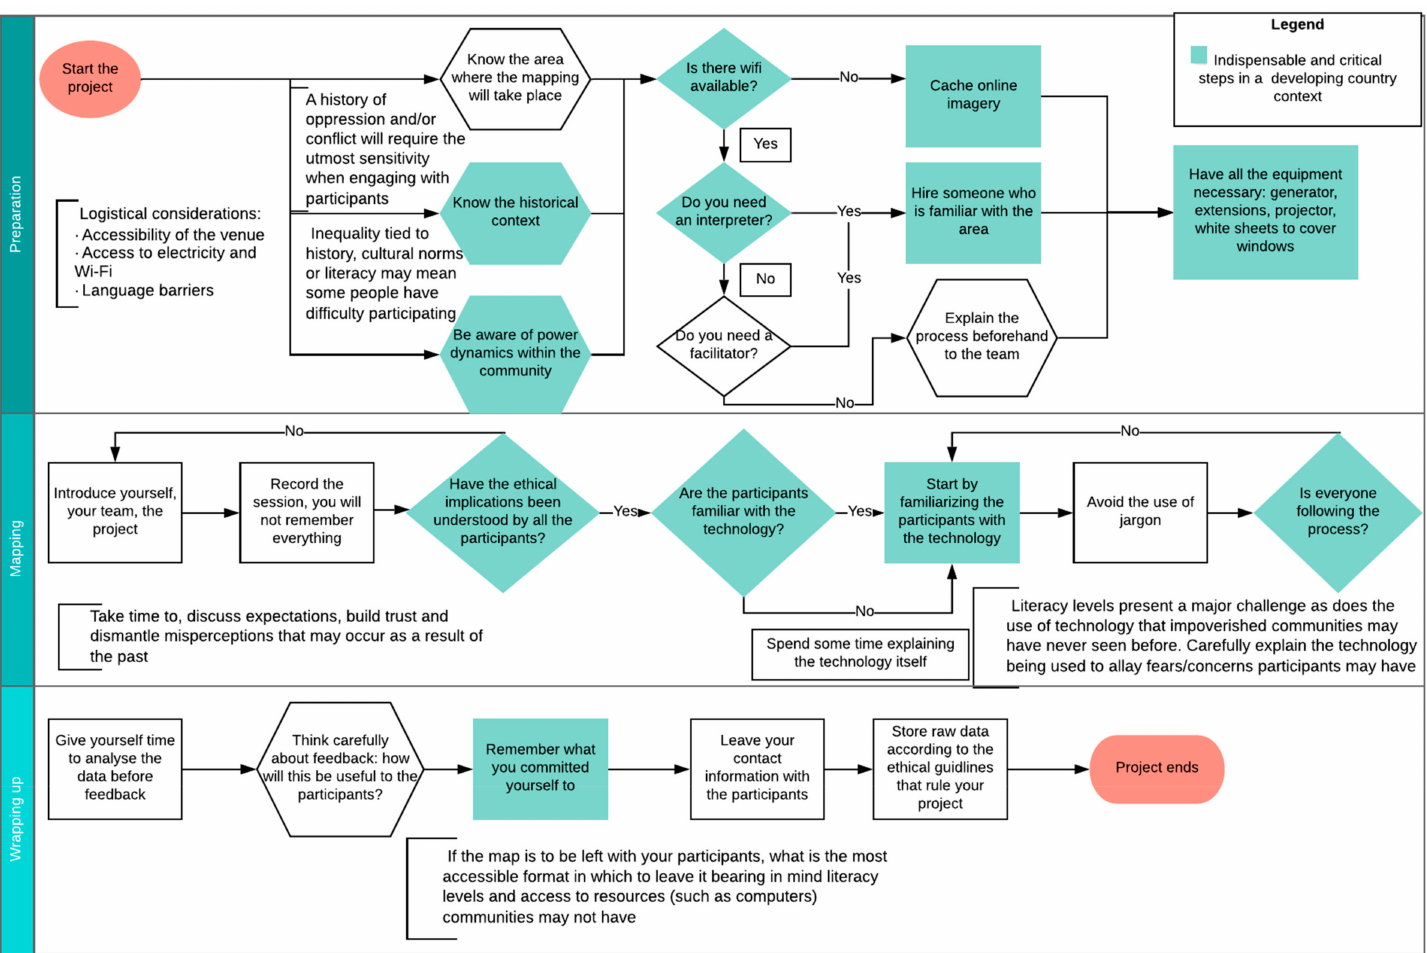
Figure 3. Flow diagram for suggested decision-making process when conducting digital participatory mapping in a developing country